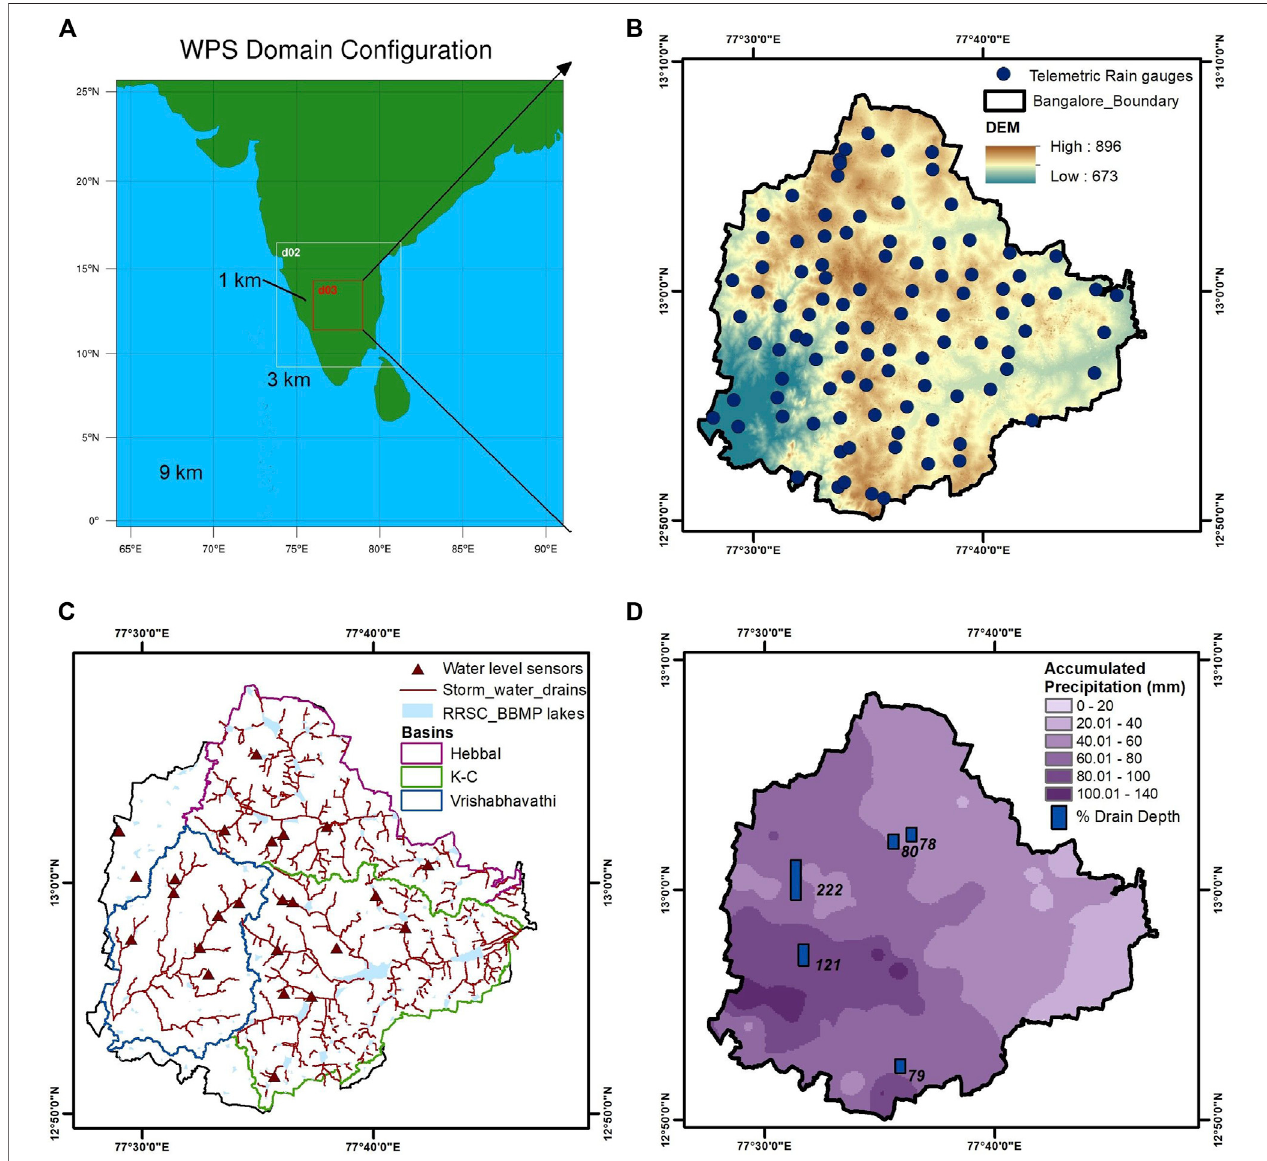
FIGURE1| Studyareaanddatausedfordevelopment,calibrationandvalidationofWRFandPCSWMMmodels. (A – D) ,WRFmodeldomaincon fi gurationusedfor simulating extreme rainfall events over Bangalore city (A) , Location of automatic rain gauges overlain over the digital elevation model (DEM) (B) , Location of water level sensors with storm waterdrainage network, valleyboundaries and lakes used for the development ofthe hydrological model (C) and Spatial map of observed rainfallfor 20 – 21 October 2020 heavy rainfall event along with observed water levels represented as the percentage of fl ow depth with respect to drain depth (D) .